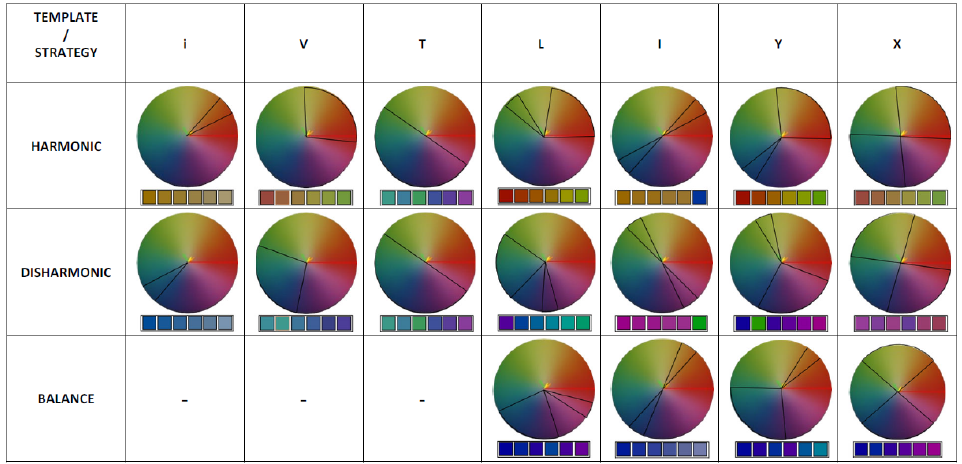
Figure 10. Color schemes and color palettes related to the painting.